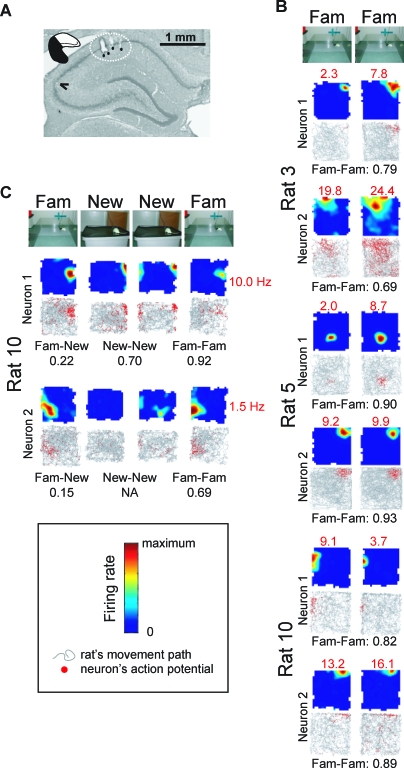
Experiment 4: Place-Related Firing of Neurons in Hippocampal Residuals at the Septal Pole(A) Cresyl-violet–stained coronal section showing the tracks of the four tetrode bundles (circled by stippled line; individual tracks indicated by black dots) used to record place-related activity from the CA1 region of the septal hippocampus; tracks were marked by passing an electric current through the tetrodes after completion of the recordings. The section is from rat 10, which had a hippocampal residual of 26% at the septal pole. A slight disruption of the CA3 layer is visible (black arrowhead), indicating the beginning of the lesion to intermediate and temporal hippocampus.(B) CA1 cells in hippocampal residuals at the septal pole show accurate and stable place-related firing in a familiar environment (Fam): Firing fields of complex-spike cells recorded from three rats (3, 5, and 10) with hippocampal residuals at the septal pole during two successive trials in the familiar environment. The color-coded firing-rate maps and, below, the location of spikes (red) on the rat's trajectory (gray) are shown for the two cells of each rat with the highest spatial-information score. The peak firing rate for each trial is indicated in red numbers above and the correlation between the firing-rate maps for the two successive trials is shown in black below. Note that neurons often changed their peak firing rate between trials, but that the firing positions remained stable. See Figure S5A and S5B for additional cells recorded from the rats with hippocampal residuals at the septal pole and for cells recorded from a control group with intact hippocampus.(C) CA1 cells in hippocampal residuals at the septal pole rapidly change their firing pattern in a new environment. Firing fields of two complex-spike cells recorded from one rat with hippocampal residuals at the septal pole (rat 10; the two neurons are not identical with the two neurons whose firing patterns are shown in [B]) during a succession of trials in the familiar (Fam) and a new (New) environment. All firing-rate maps are scaled to the same maximum firing rate, equal to the maximum of all four trials and indicated in red to the right; correlations between the firing-rate maps for different trials are indicated in black below. Note that neuron 1 forms a new place field in the new environment, whereas neuron 2 becomes nearly silent. See Figure S6 for additional cells from rat 10 and from two control rats with intact hippocampus.